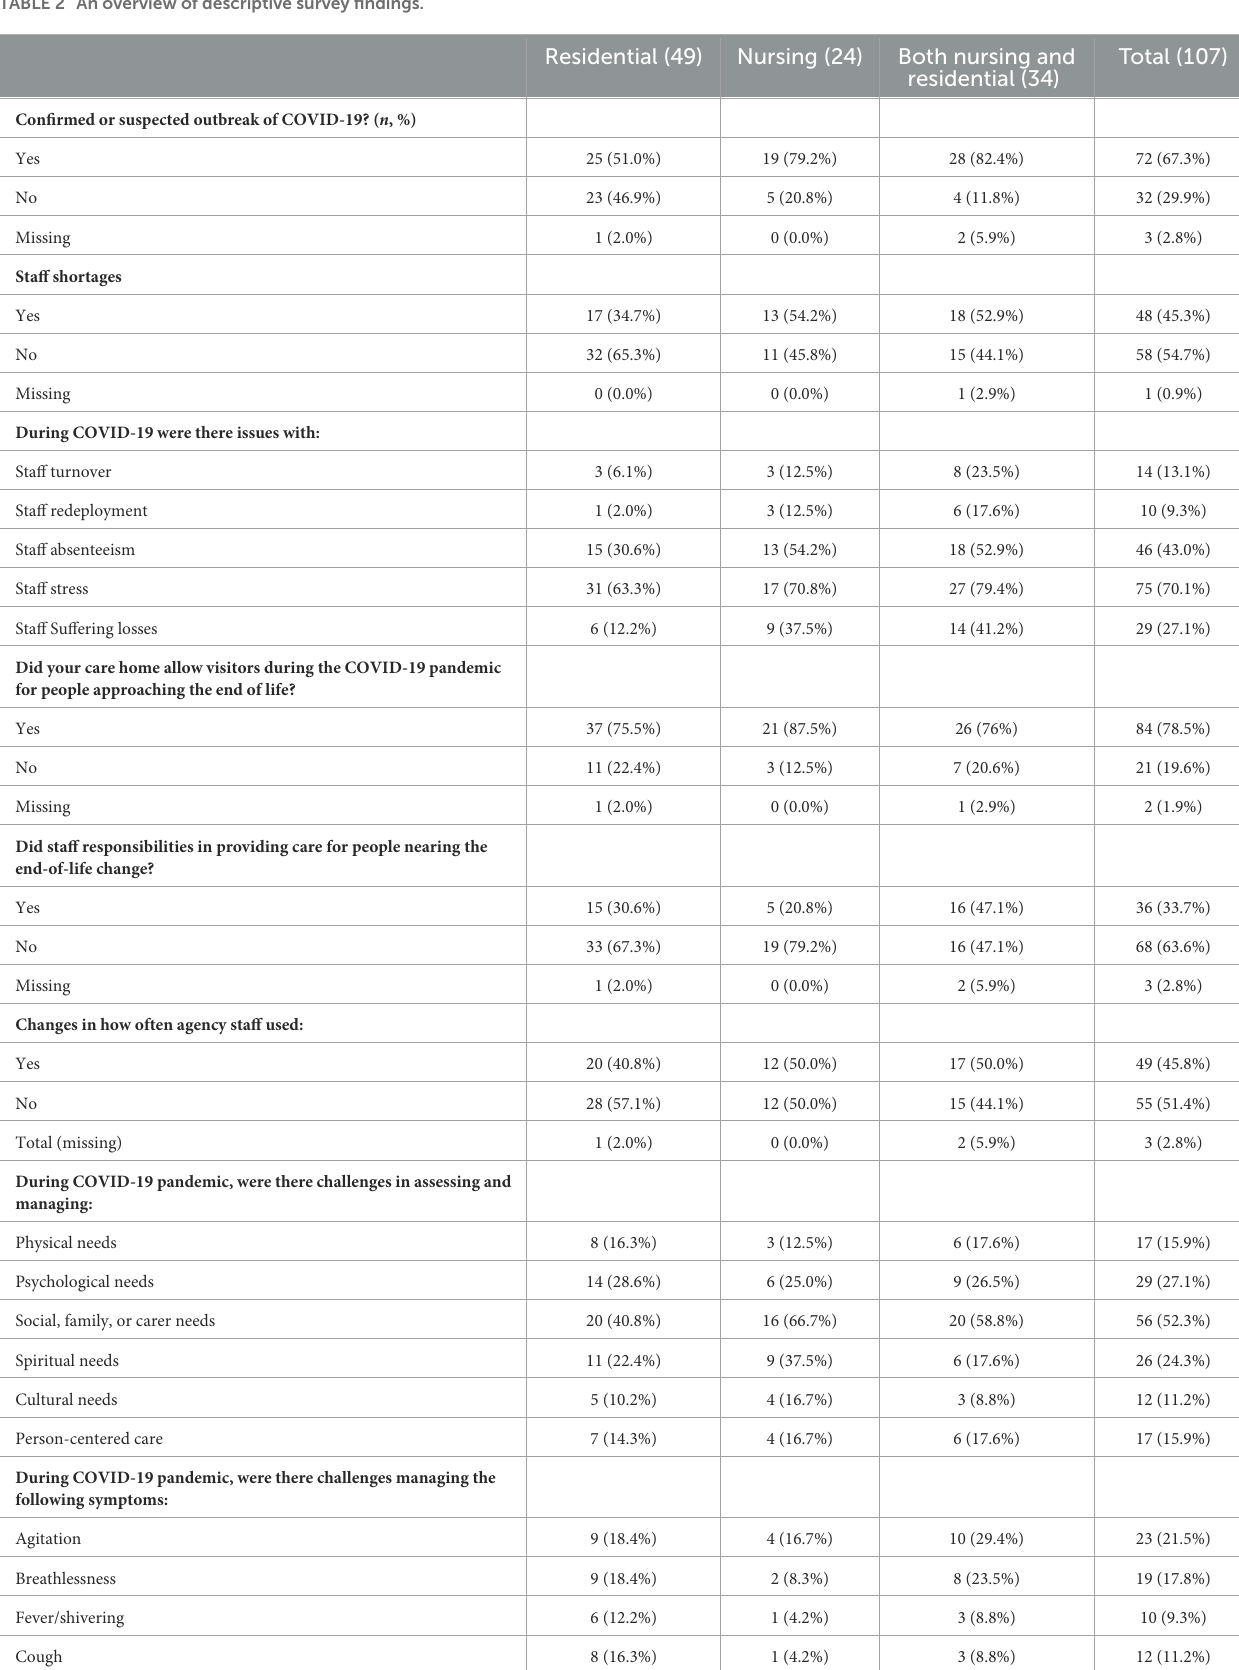
TABLE 2 An overview of descriptive survey findings.